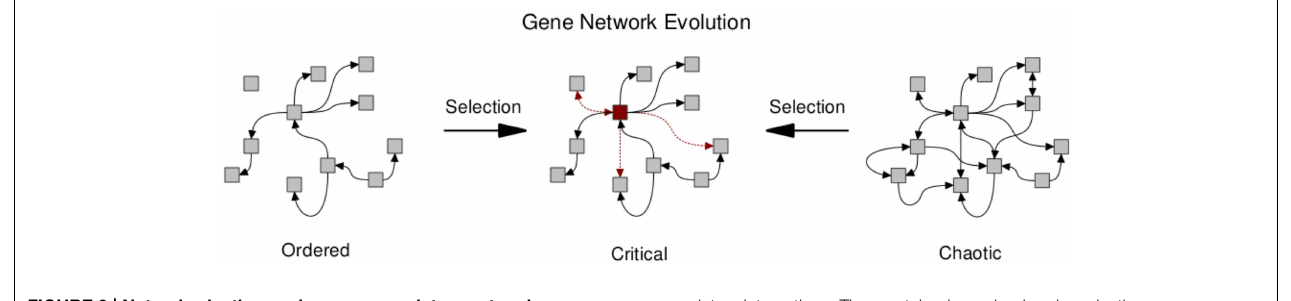
regulatory interactions. Those retained or gained under selection are highlighted (red dashed). The manifestation of hub-like nodes (red square) has been observed under simulations of network evolution (Torres-Sosa et al.,